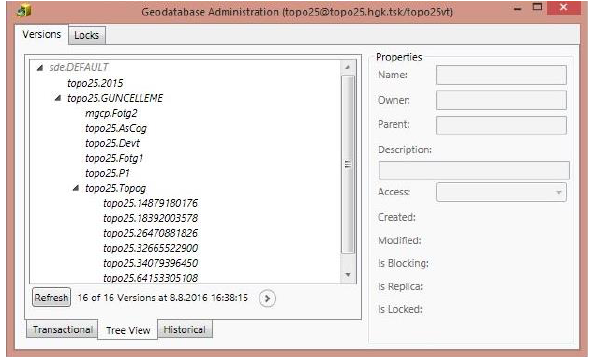
Figure 2. WMS service version